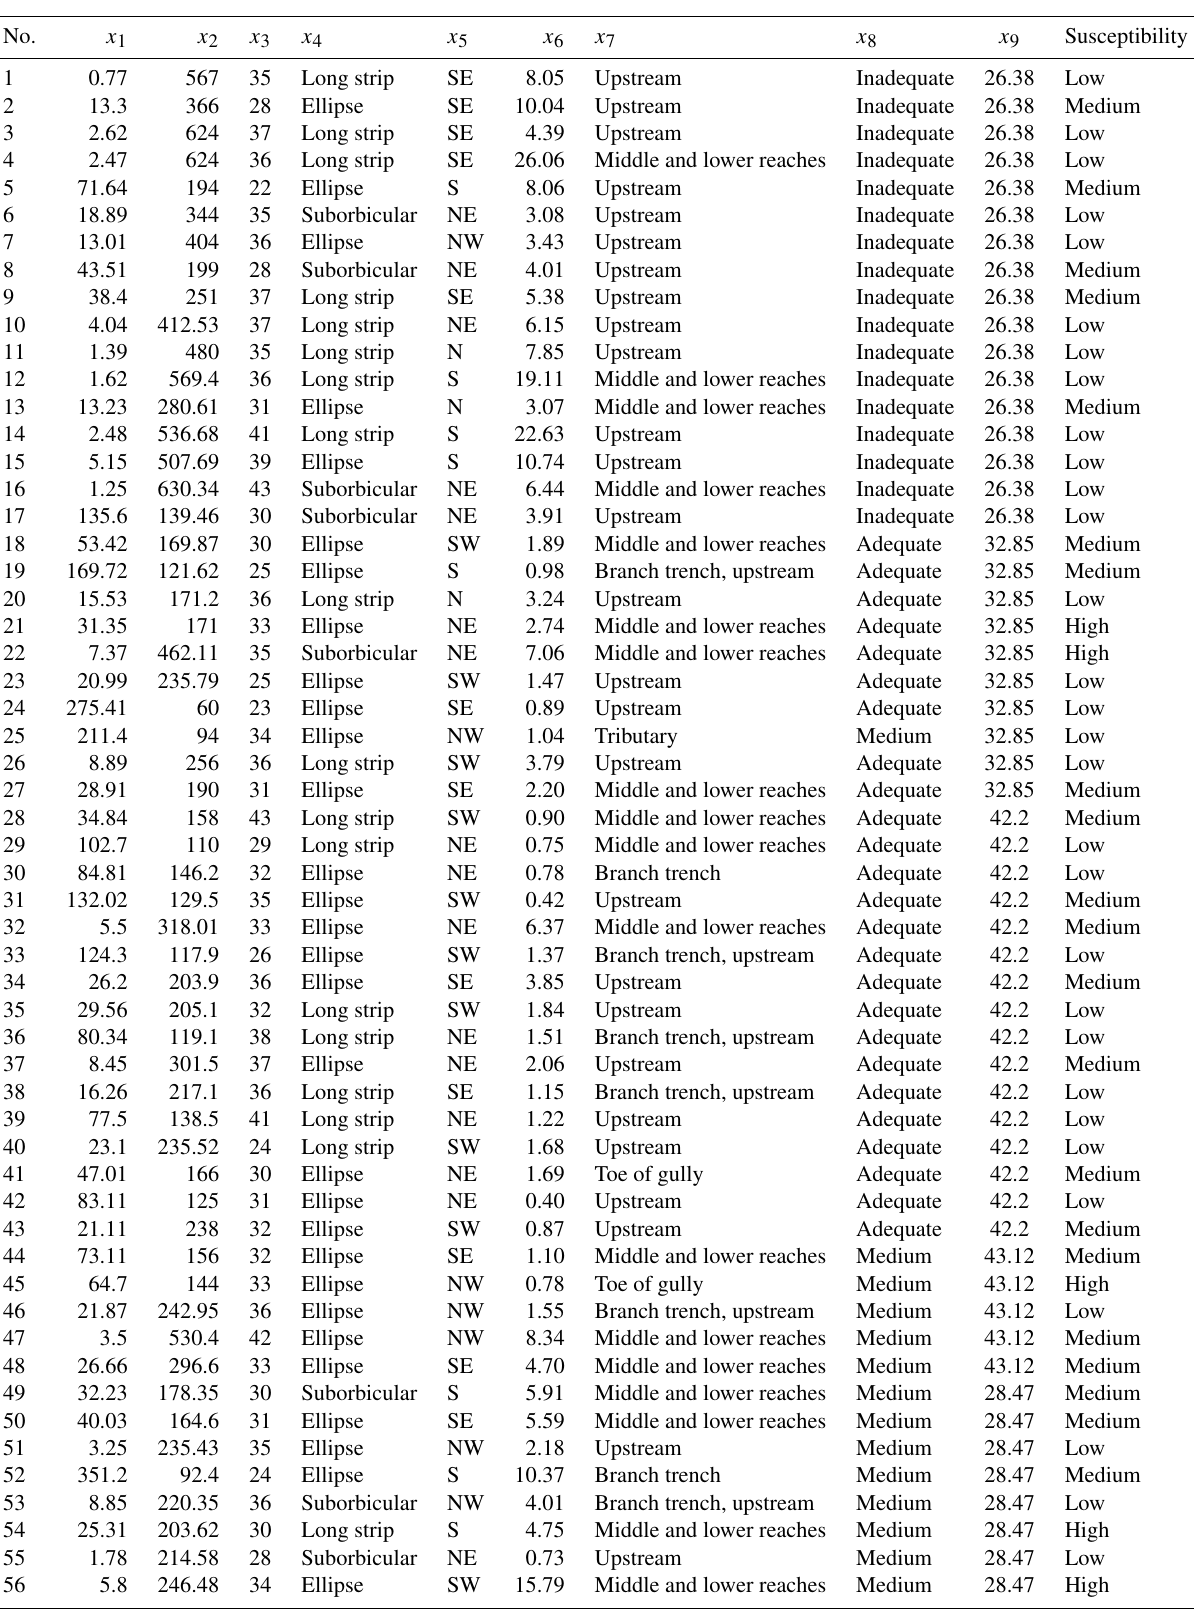
Table 5. Sample data for debris flow examples from southwestern